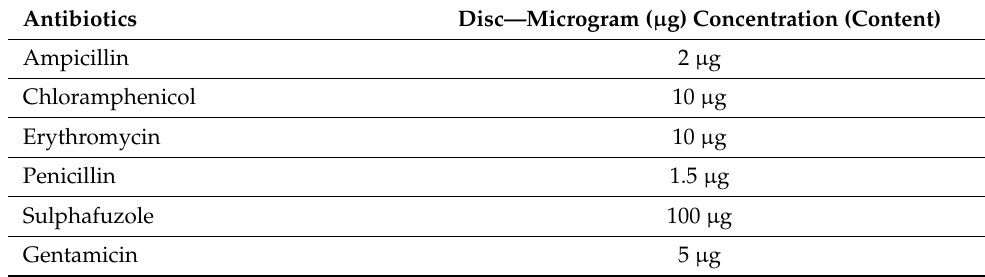
Table 1. Antibiotic discs and concentration used for antimicrobial resistance testing of water samples taken in Freetown Sierra Leone. Antibiotics Disc—Microgram ( µ g) Concentration (Content) Ampicillin 2 µ g Chloramphenicol 10 µ g Erythromycin 10 µ g Penicillin Sulphafuzole Gentamicin 5 µ